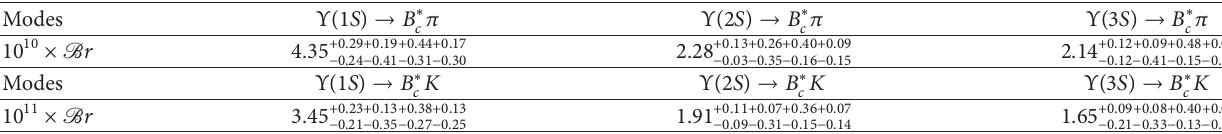
Table 3: Branching ratio for Υ(𝑛𝑆) → 𝐵 ∗ 𝑐 𝑃